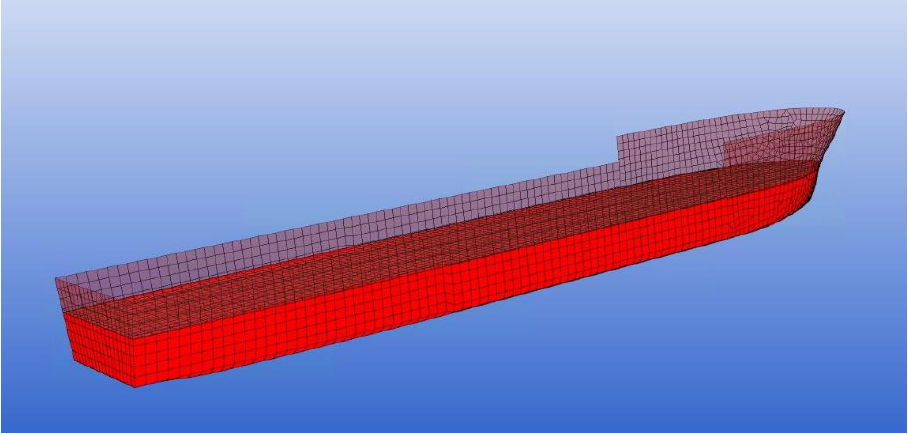
Figure 2. The panel model used for the hydrodynamic analysis.